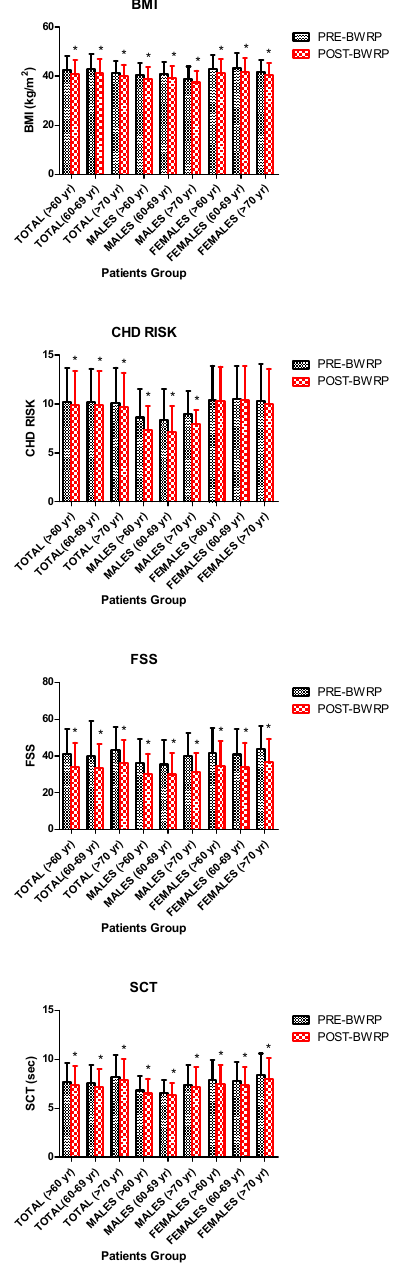
Figure 2. Body mass index (BMI, top panel), coronary heart disease risk (CHD RISK, top middle panel), fatigue severity scale (FSS) score (bottom middle panel) and stair climbing test (SCT) time (bottom panel) before and after a three-week body weight reduction program (BWRP) in elderly obese females and males. Data are expressed as mean ± SD. The values corresponding to each gender- and age-related subgroup (total, females / males, > 60 years, 60–69 years and > 70 years) are reported. * p < 0.01 compared to before body weight reduction program